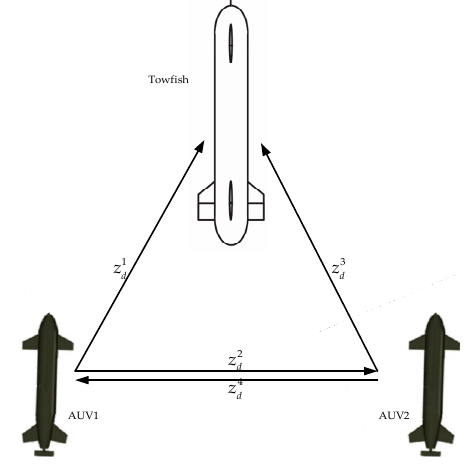
Figure 8. Formation structure.